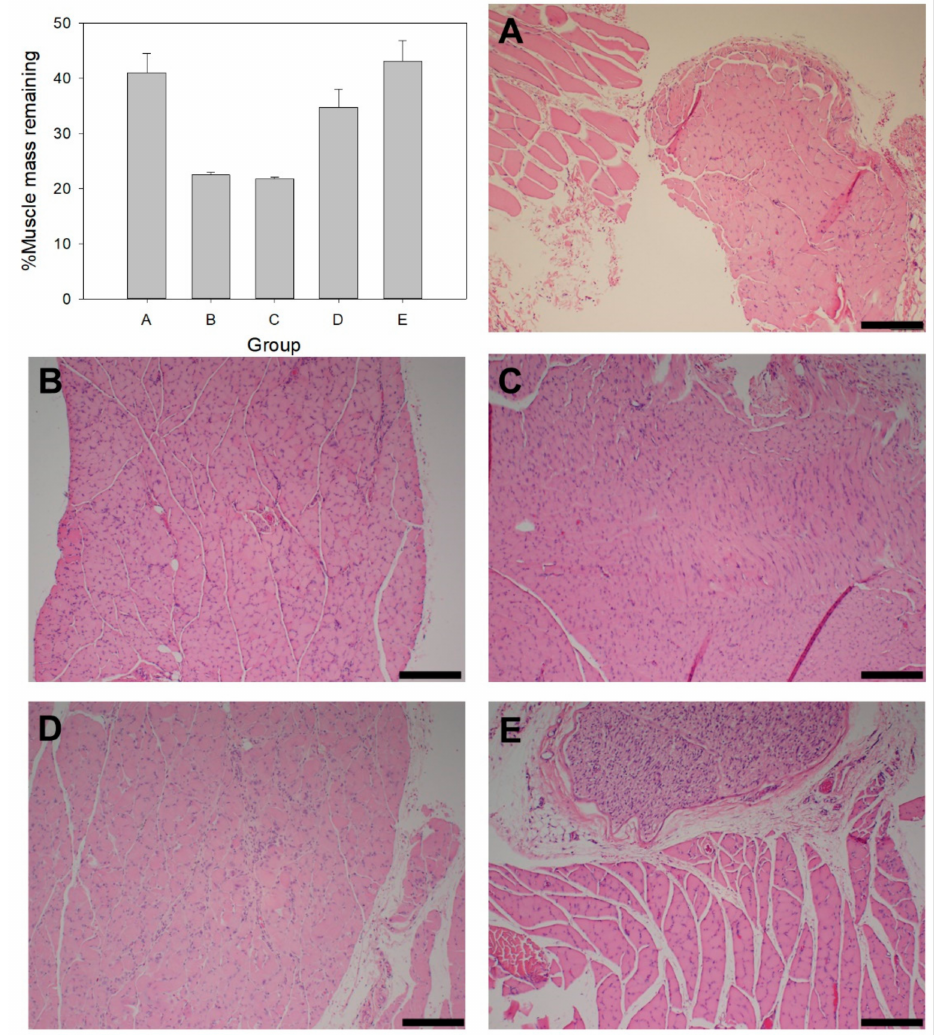
Figure 7. %Muscle mass remaining and histological images of gastrocnemius muscle tissue at 28 days in Groups ( A – E ) (Scale bar= 200 µ